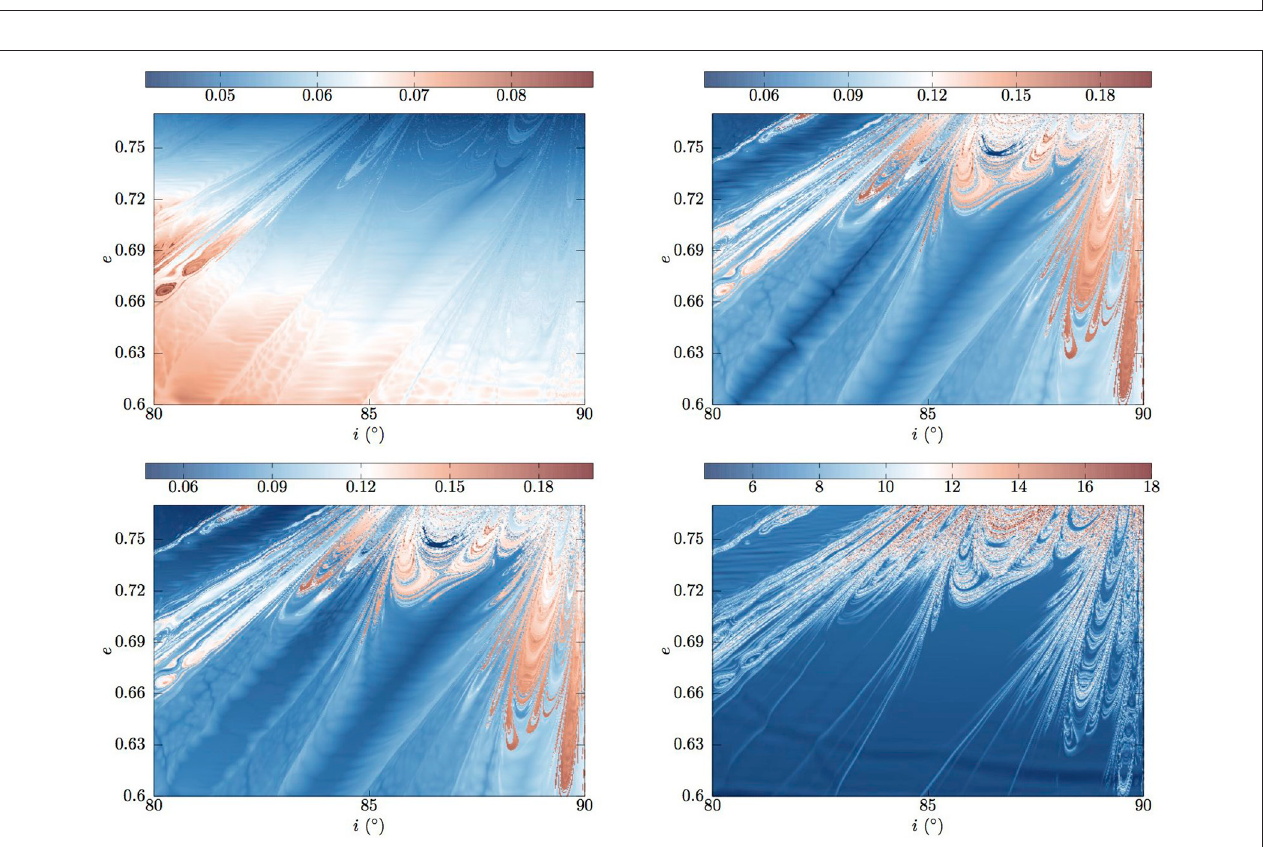
FIGURE 8 | The figures enable us to quantify how a one-dimensional diameter coefficient (here based on the action G , top left) may be inappropriate in some cases in capturing dynamical properties. A contrario , the two-dimensional diameter coefficient (bottom left) based on both actions, G and H , captures the subtleties of the dynamics and reconcile the results with the FLIs